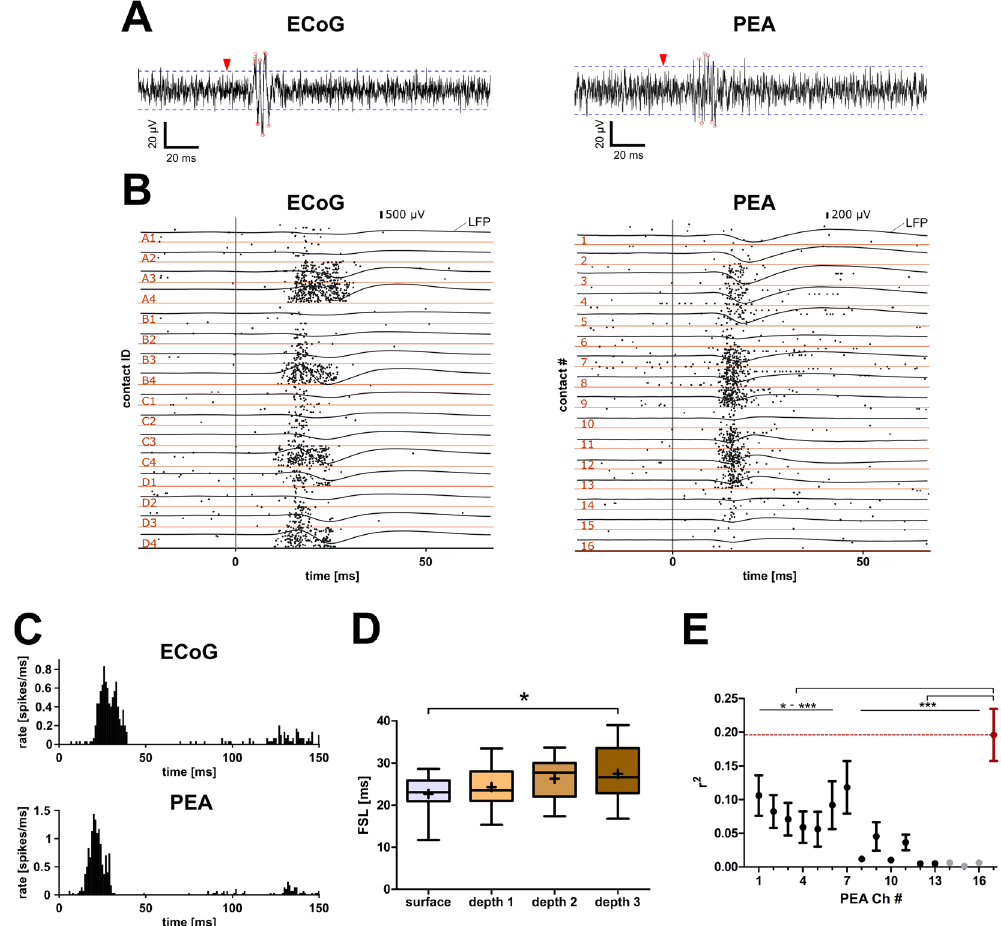
Figure 5. The newly developed ECoG grid enabled recordings of evoked MUA similar to conventional penetrating multi-electrode arrays. ( A ) Examples of filtered (300–3000 Hz) traces with detected spikes (red circles) above detection threshold (dashed line) for both ECoG and penetrating multi-electrode array (PEA). Stimulus onset is indicated (red arrow head). ( B ) Representative examples of averaged LFP and raster-plots of MUA in response to a broad-band noise stimulus of 80 dB SPL rms . The raster-plots indicate the time points of every detected spike in each of the 30 repetitions. Stimulus onset is indicated (vertical line). ( C ) The peri- stimulus time histograms (psth) show representative responses to a 100 ms broad-band stimulus, for the ECoG grid and the penetrating electrode (PEA), respectively. Usually a strong onset response and a weak offset response were discernable. ( D ) Similarity between first spike latency (FSL) for ECoG grid and penetrating multi-electrode array contacts decreases with cortical depth (depth3 = infragranular layer). Given are median FSLs at the best frequency threshold level (i.e. 10% of max MUA, comparable to the CF threshold) for ECoG grid recording sites close to the insertion point and for different depths at the PEA (depth 1: 0–600 µ m, depth 2: 750–1200 µ m, depth 3: 1350–1800 µ m). Box-plots with min and max values (whisker) and mean (cross). The FSL at the surface was significantly shorter than the one recorded in deep layers of the AC; dependent t-tests with Bonferroni correction * p < 0.05. ( E ) Correlation strength (r 2 ) between grid and penetrating electrode recordings for MUA is highest for granular layers (contact #7). Given are mean (dot) and SEM (whisker). After an initial decline in correlation strength, the maximal correlation was reached at the 7 th contact and sharply declined with increasing cortical depth (contacts #14–16, indicated in light grey, were excluded from further analyses). ANOVA with Bonferroni corrected posttest: * p < 0.05, ** p < 0.01, *** p <